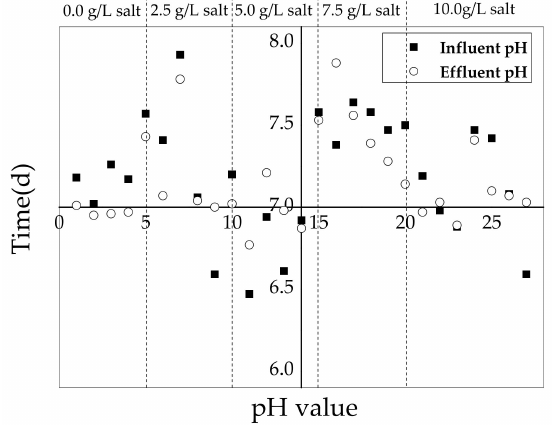
Figure 6. Variation of pH (potential of hydrogen) at varying